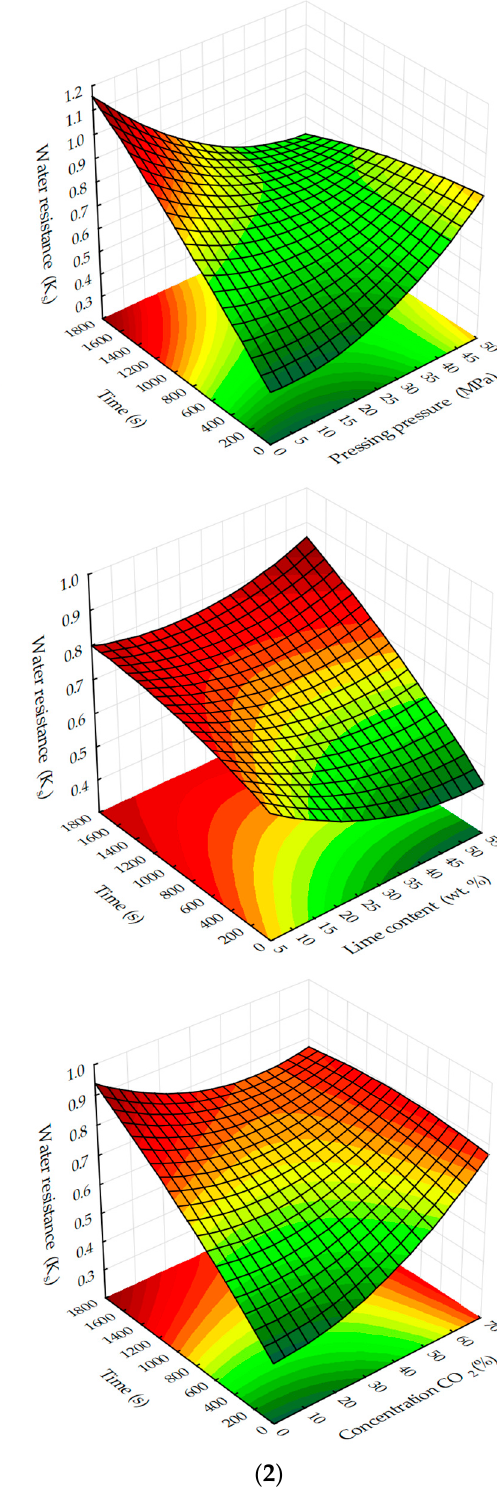
Figure 8. Response surfaces to changes in the water-resistance of testing samples carbonated by dynamic ( 1 ) and static ( 2 ) methods, depending on the number of cycles/time of carbonation and: ( a ) pressing pressure; ( b ) lime dust content; ( c ) CO 2 concentration (at zero level of variation of other factors).